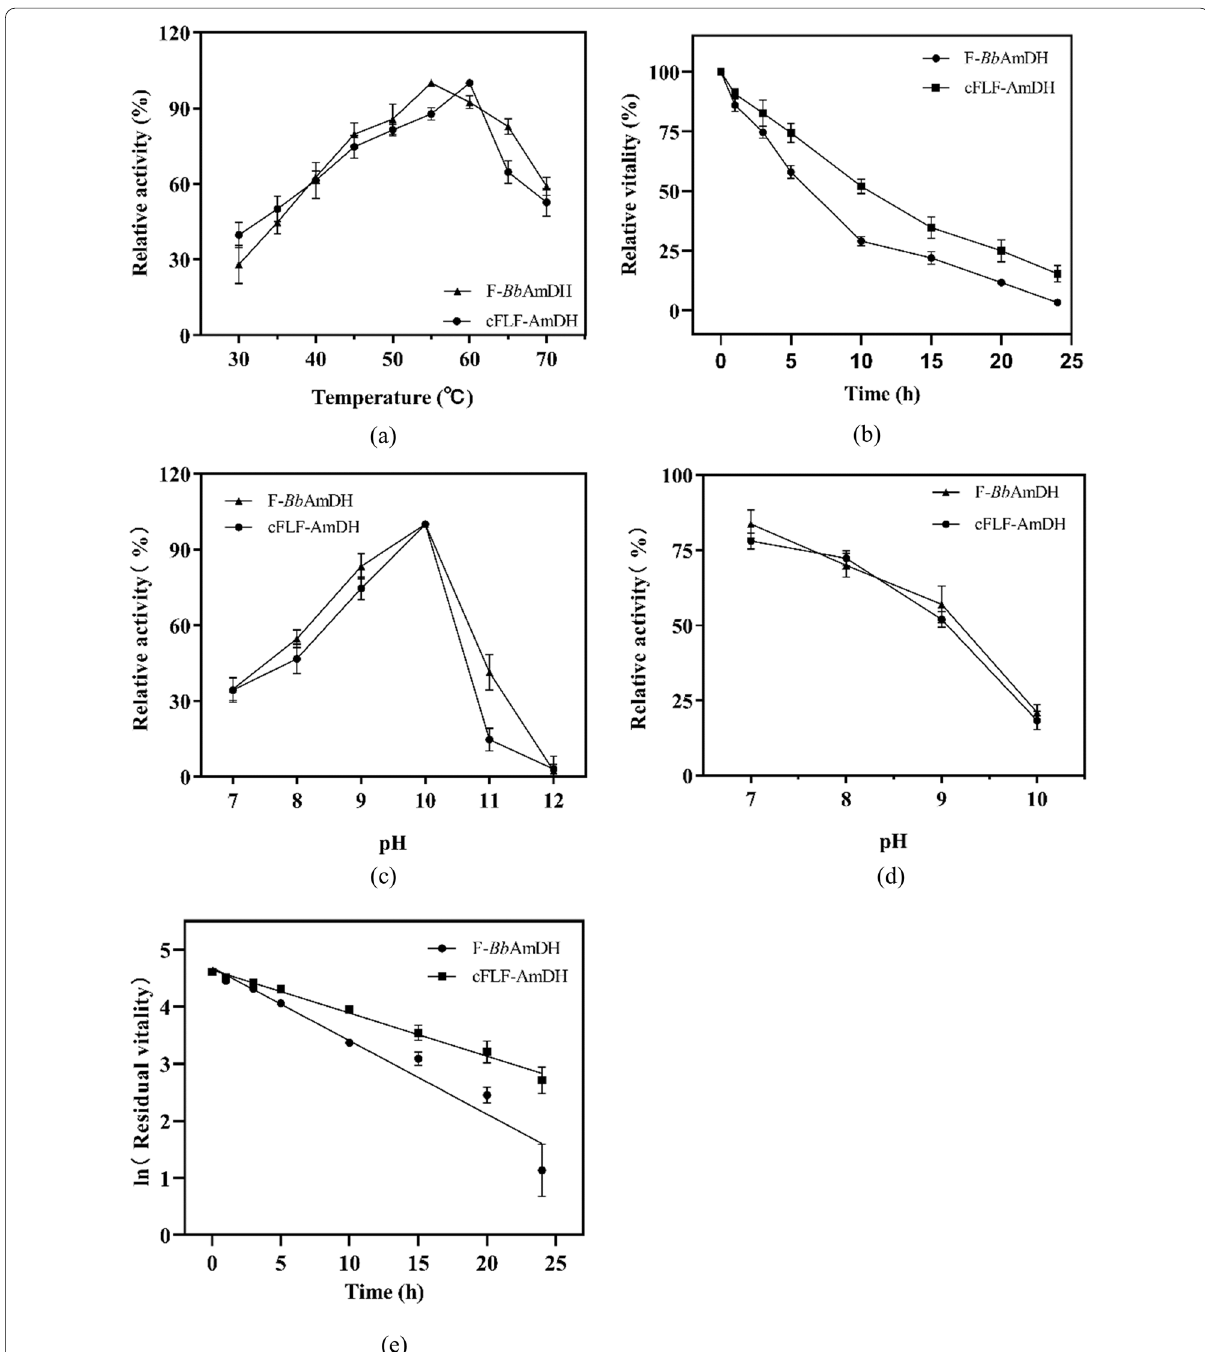
Fig. 2 Comparison of enzymatic properties of cFLF-AmDH and F- Bb AmDH. a Optimum reaction temperature. b Temperature stability. c Optimum reaction pH. d pH stability. e Half-life. The error bars showed the standard deviations of three